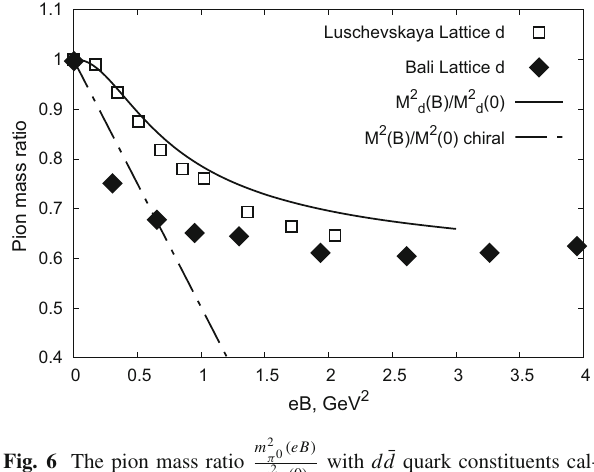
Fig. 4 The decay constants quarkconstituentscalculatedwithECLincomparisonwiththestandard chiral perturbation theory ( a ) K f